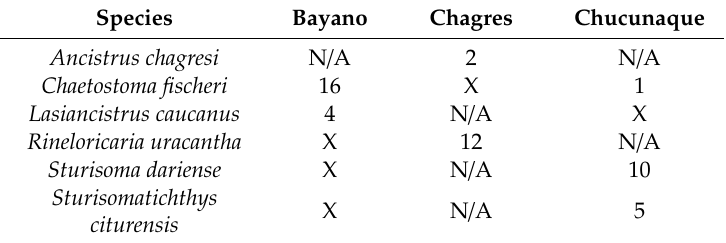
Table 2. Number of individuals of each species collected for stoichiometric and isotopic trait sampling in each major watershed. Cells marked “X” indicate that the species was collected within that watershed but not measured in this study while cells marked with “N / A” indicate that the species was not found by us and is not known to occur in that watershed. We also measured nutrient excretion rates of three individuals of Hemiancistrus aspidolepis but omit them from our analyses due to a lack of body stoichiometry data for that species. Species Bayano Chagres Chucunaque Ancistrus chagresi N / A 2 N / A Chaetostoma fischeri 16 X 1 Lasiancistrus caucanus 4 N / A X Rineloricaria uracantha X 12 N / A Sturisoma